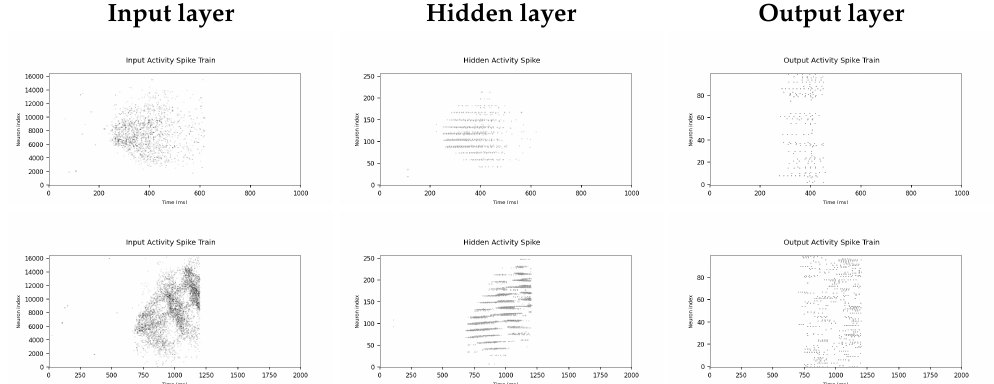
Figure 7. Spike raster plots representing the spiking data as they pass through each layer of the SNN. The left panel displays spikes in the input layer, the middle panel in the hidden layer, and the right panel in the output layer. The top row shows data for the tapping experiment and the bottom row for the sliding